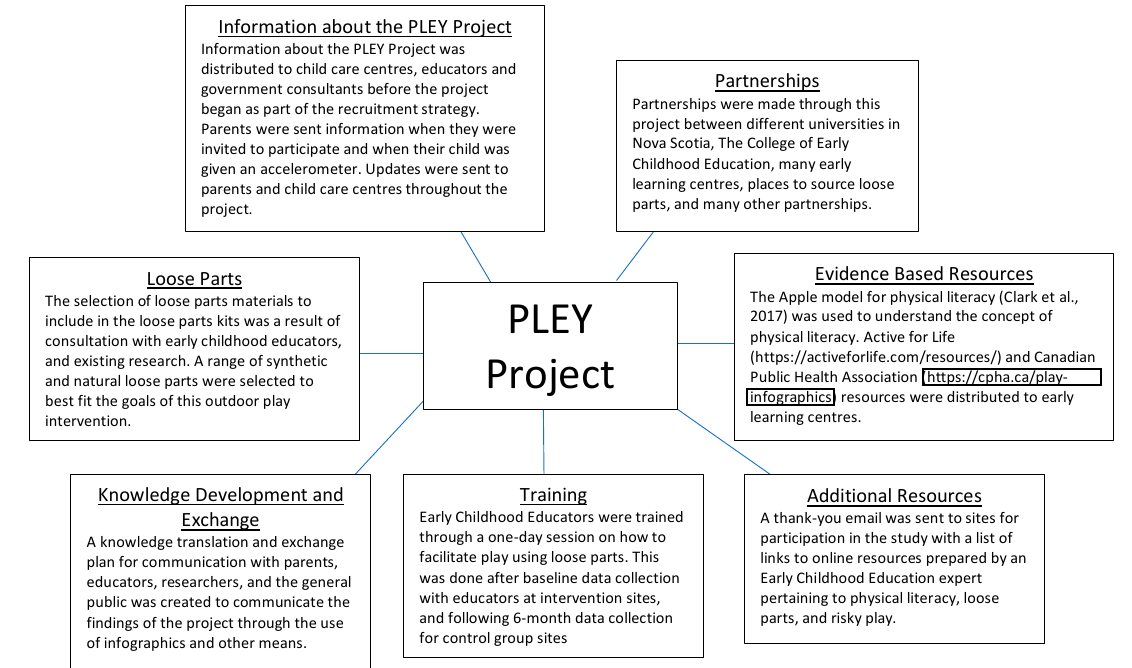
Figure 2. PLEY project components